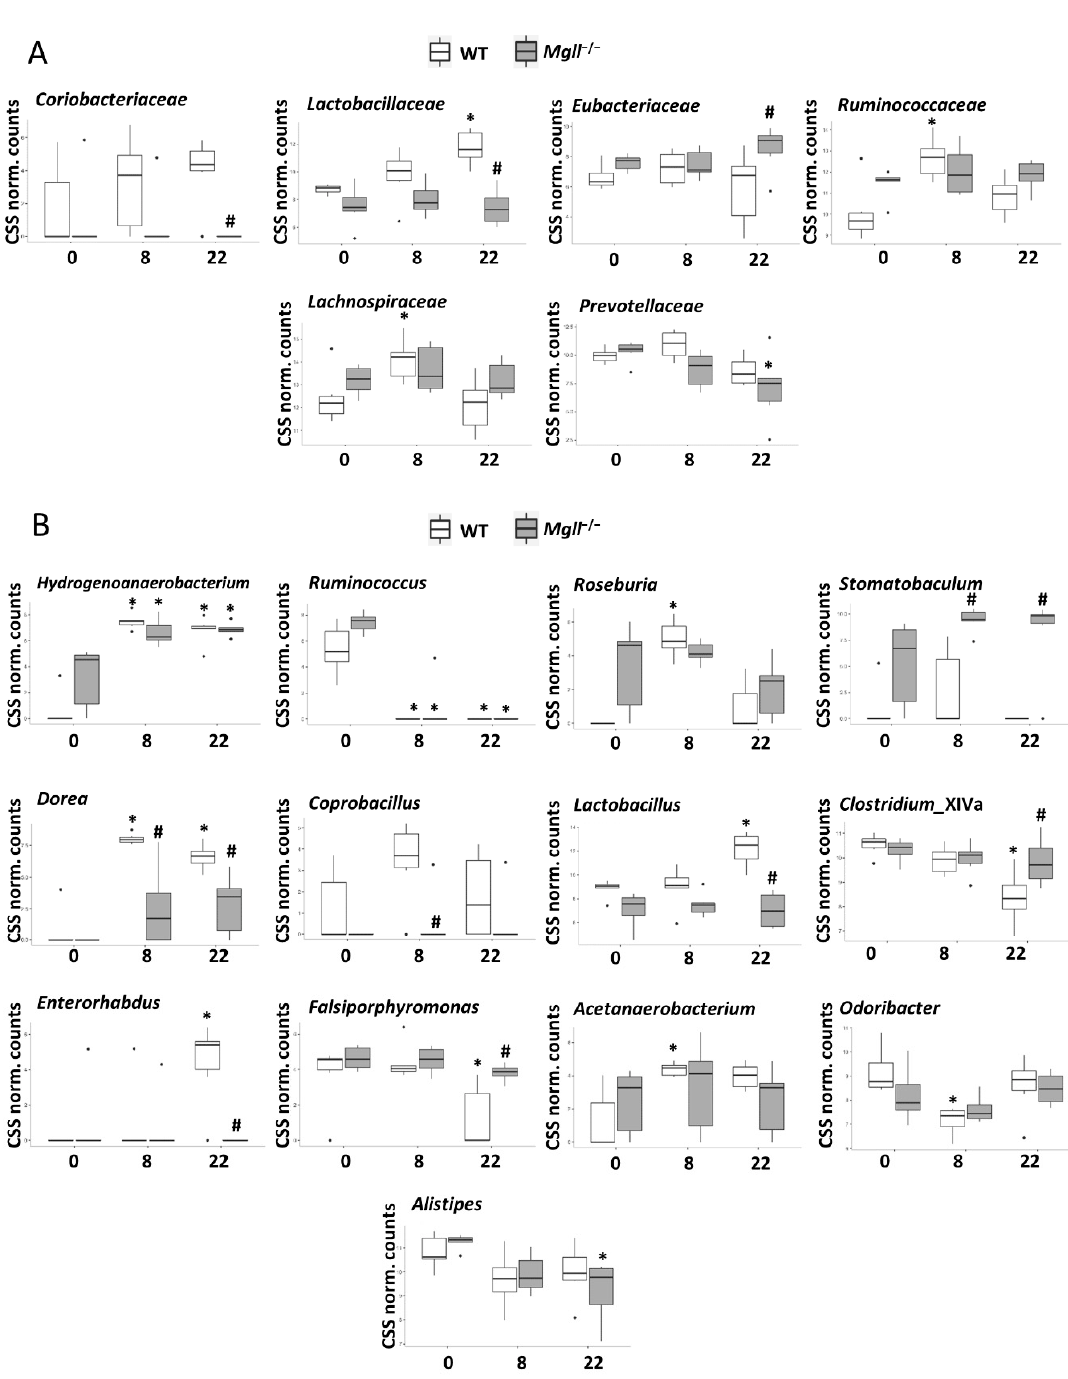
Figure 4. Bacterial taxa are differentially abundant within WT and Mgll − / − mice on chow and HFD feeding. Fecal microbiomes were characterized in WT and Mgll − / − mice under chow diet feeding (0) or HFD-feeding for 8 weeks (8) or 22 weeks (22) via 16rDNA sequencing. ( A , B ) Prevalence of bacterial families ( A ) and genera ( B ) showing differences between genotypes under the different diets or different responses to HFD feeding. * p < 0.05 vs. relevant chow control, # p < 0.05 vs. relevant WT control.